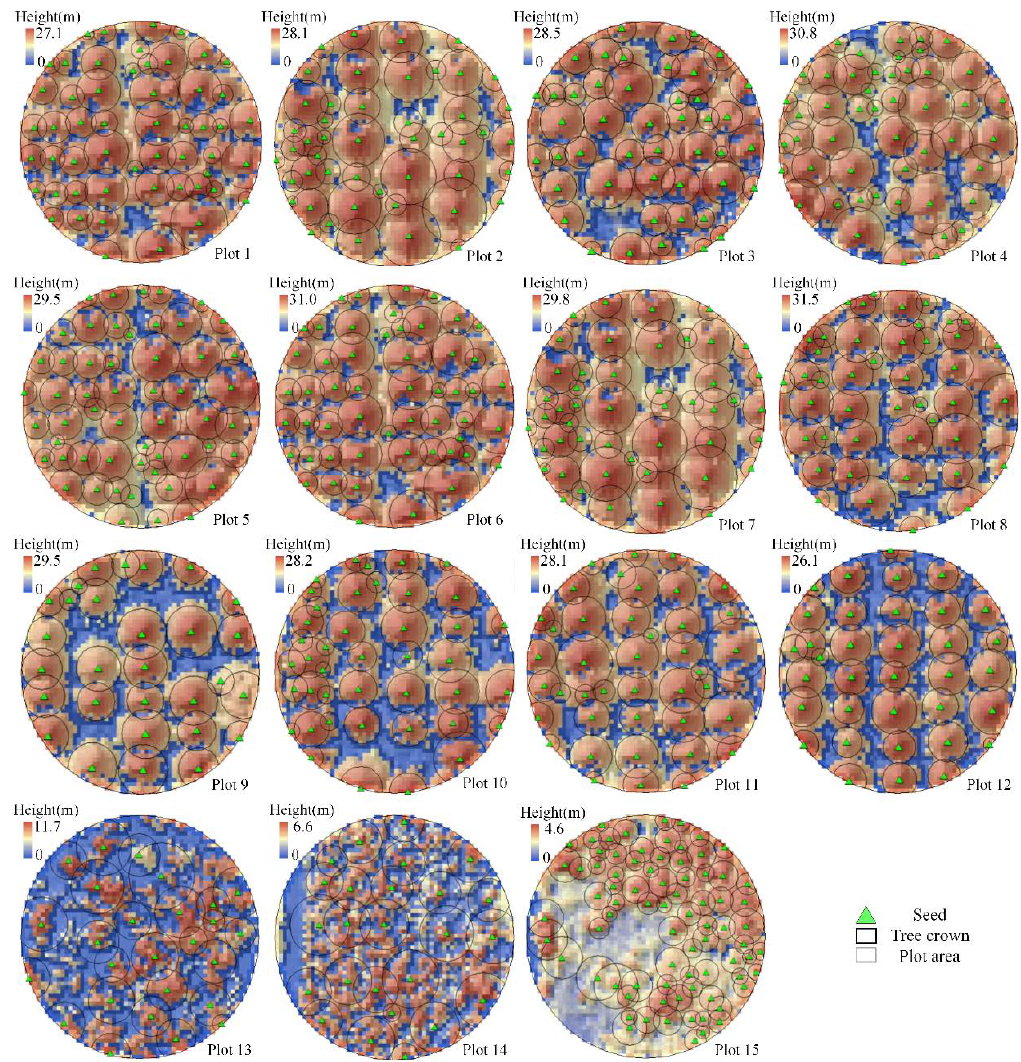
Figure 9. Individual tree segmentation results of 15 sample plots.